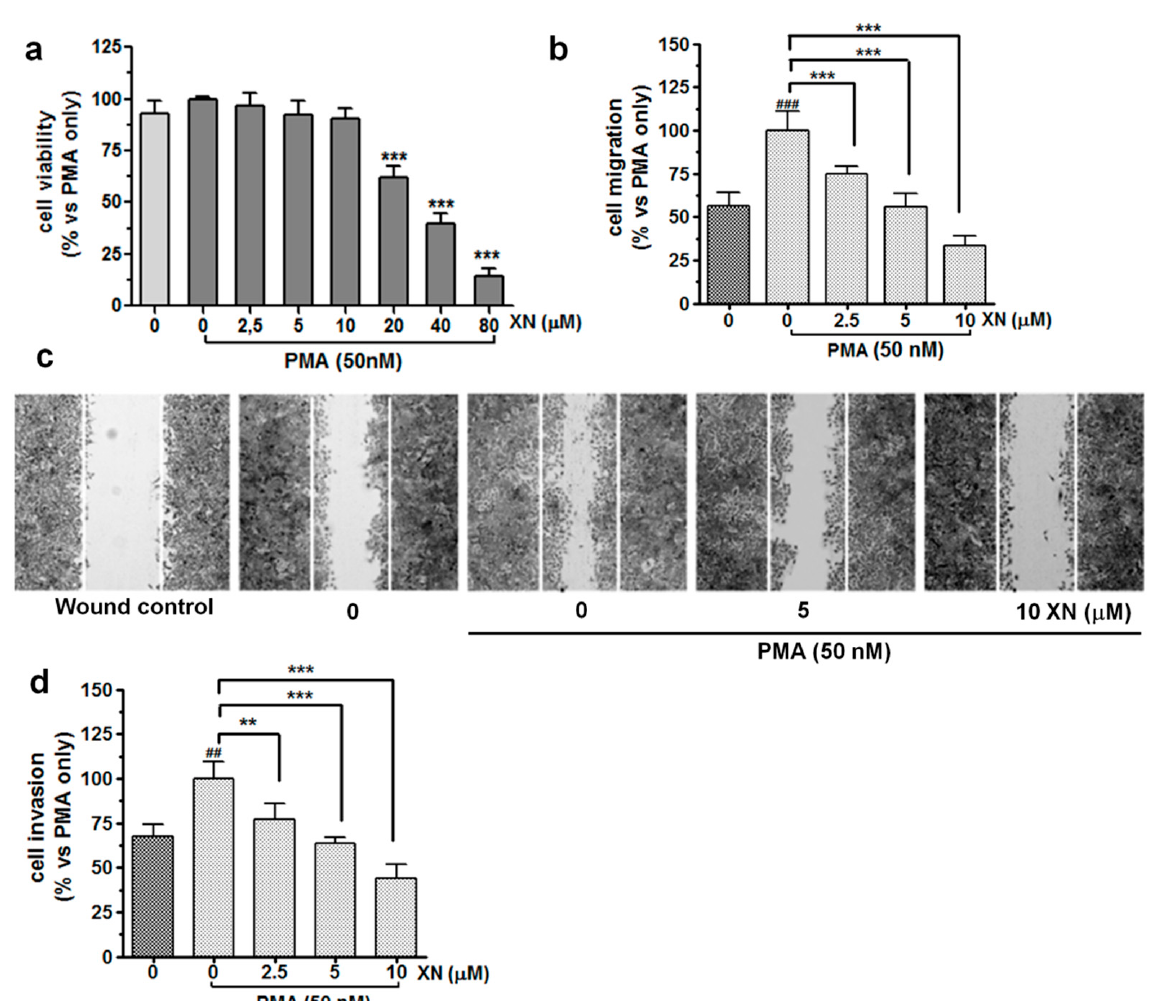
Figure 1. Impact of XN on the viability, migration, and invasion of PMA-induced A549 cells. ( a ) The effect of XN on the viability of PMA-induced A549 cells was determined with the MTT assay following 24-h exposure of these cells to a combination of different concentrations of XN (0–80 µ M) with 50 nM PMA. The percentage of cell viability was calculated as a ratio of XN+PMA-treated cells to the PMA-only treatment. Data are expressed as the mean ± SD of three independent experiments, *** p < 0.001 in comparison to the PMA-only treated cells; one-way ANOVA test. ( b ) XN significantly decreases the PMA-activated cell migration in the wound healing assay. The bar graphs represent the number of migrated cells that were pre-treated for 4 h with the non-toxic concentrations of the compound before the 24-h co-incubation with PMA. Values are presented as the mean ± SD of three independent experiments, *** p < 0.001 in comparison to the PMA-only treatment; ### p < 0.001 in comparison to the non-stimulated cells; one-way ANOVA test. ( c ) Images of the migration (40-fold magnification) taken under a light microscope. ( d ) XN inhibits PMA-induced invasion of A549 cells in a concentration- dependent manner. After the treatment, the invasion of the cells was measured using a matrigel-based transwell invasion assay. The results are presented as the mean ± SD of three independent experiments, ** p < 0.01, *** p < 0.001 in comparison to the PMA-only treatment, ## p < 0.01 in comparison to the non-stimulated cells; one-way ANOVA